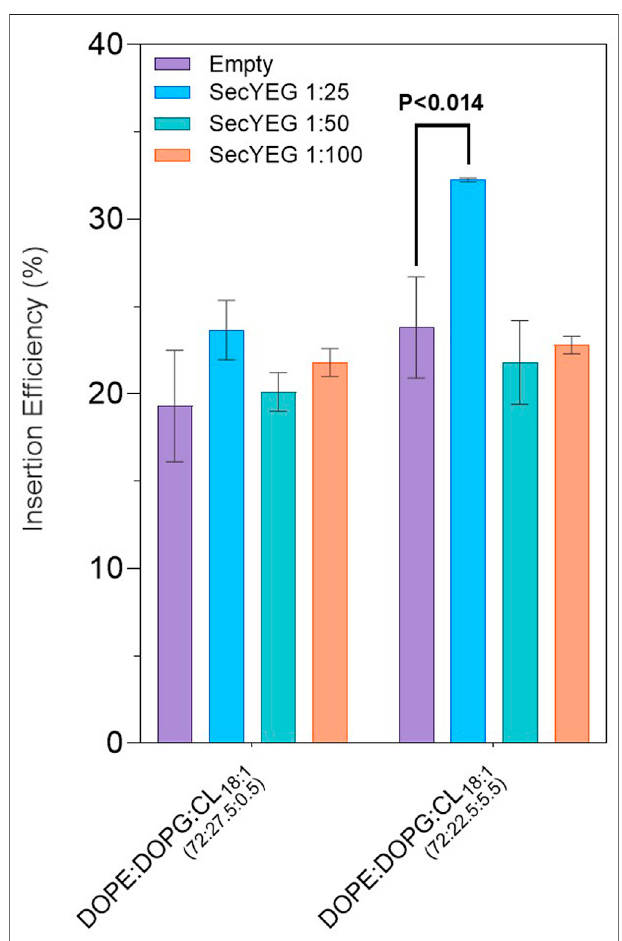
FIGURE 3 | LeuT expression in EXPRESSway ™ IVTT systems with SecYEGreconstitutedliposomes,aspresentedin Table3 and Table4 .CL 18: 1 was added into DOPE:DOPC lipid mixes at either 0.5 or 5.5% concentrations. In empty conditions, SecYEG was absent. In SecYEG conditions, SecYEG was reconstituted at a 1 in 25, 1 in 50, or 1 in 100 (w/w) protein: lipid concentration. Errors presented are SEM calculated from ≥